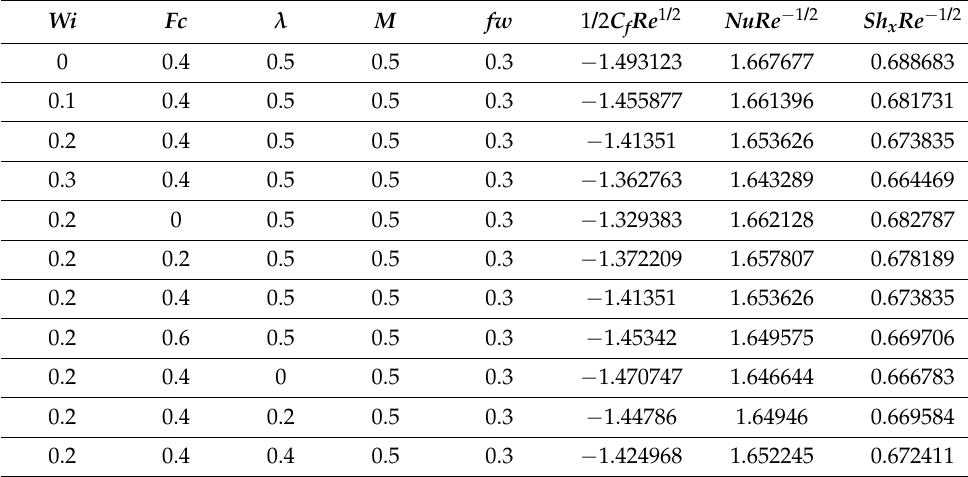
Table 2. Numerical analysis of 1/2 C f Re 1/2 , NuRe − 1/2 , and Sh x Re 1/2 for different parameters Wi , Fc , λ , M , and fw